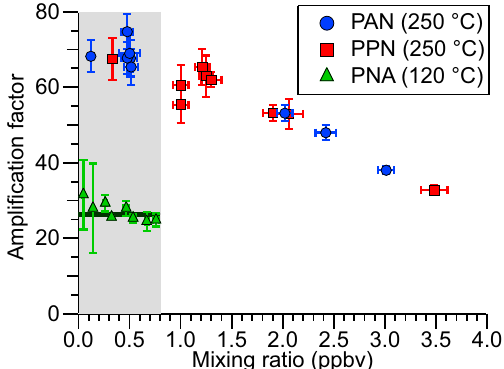
Figure 9. TD-PERCA-CRDS amplification factor as a function of relative humidity at an ethane mixing ratio of 1.6% and with NO mixing ratios of 644 ± 2 and 316 ± 3ppbv for the PAN / PPN ex- periments and the PNA experiments, respectively. The PAN and PPN mixing ratios were 0.120 ± 0.007 and 0.333 ± 0.030ppbv, respectively. The PNA mixing ratio was varied between 0 and 0.6ppbv. The room temperature HO 2 data are from Wood et al. (2016).